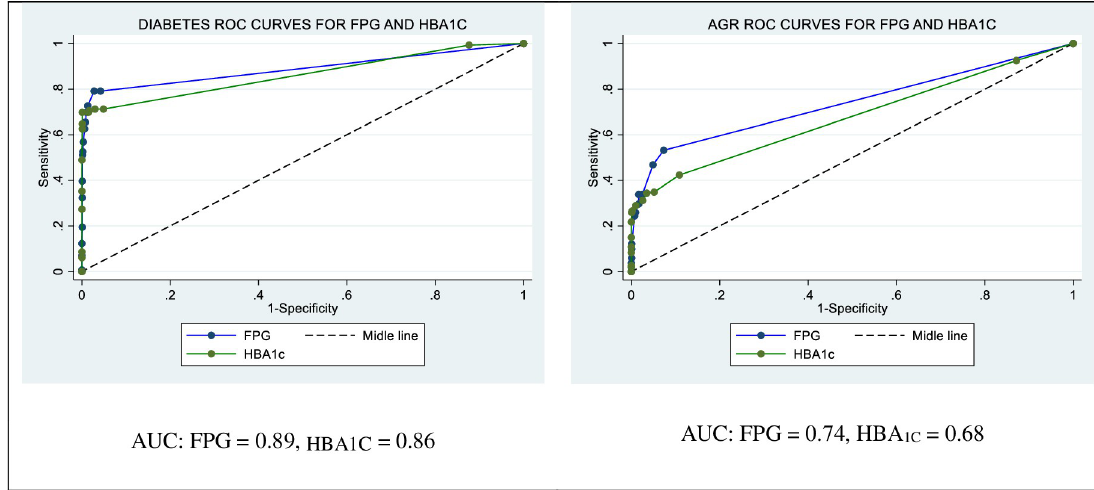
Fig 2. ROC curves for FPG and HBA 1C in the diagnosis of diabetes and